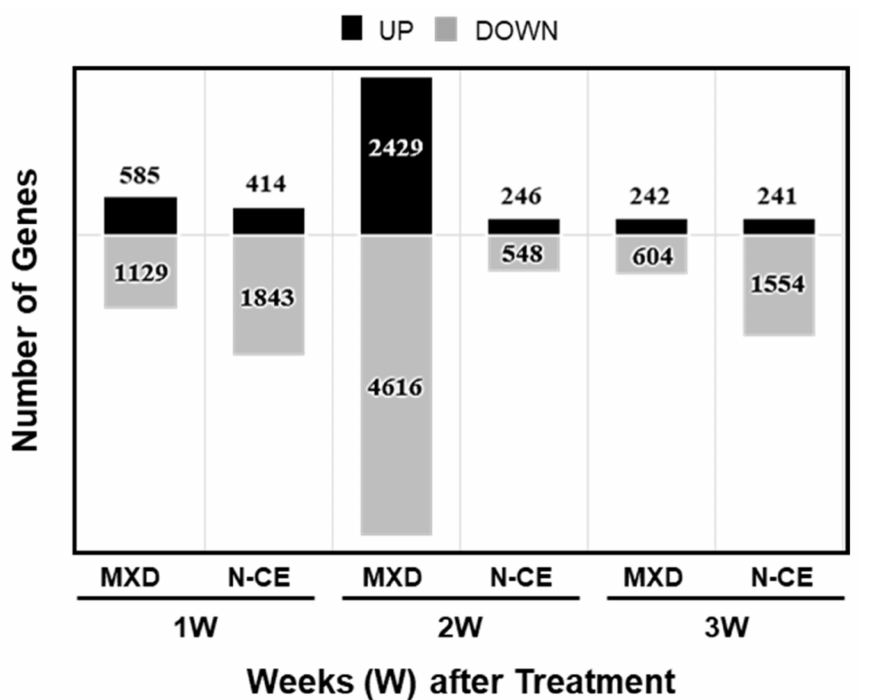
Figure 3. Time course profiling of the genes up- and down-regulated in the N-CE and MXD group 1 week, 2 weeks, and 3 weeks after treatment (see also Tables 2 and 3 below). DNA microarray was performed as described in the Section 4. Table 2. Top 20 variable genes changed by MXD at 1W, 2W, and 3W